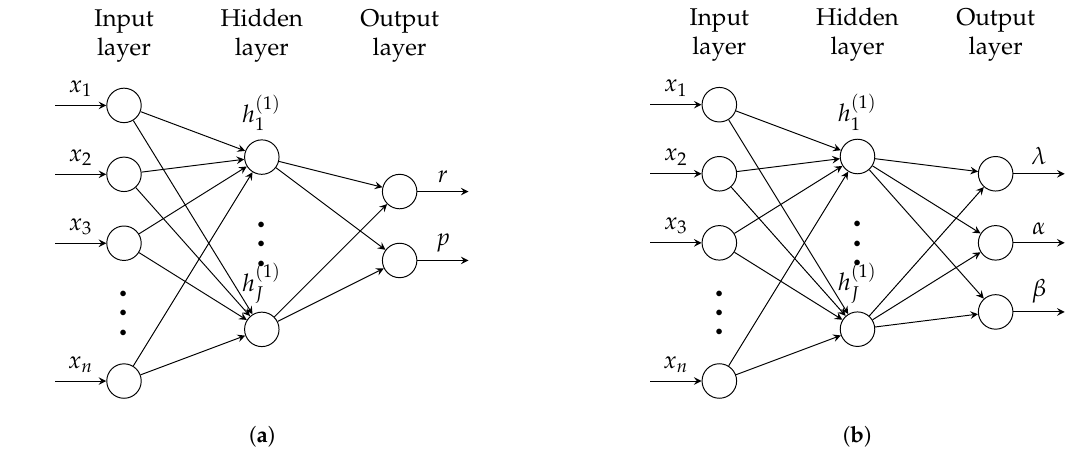
Figure 7. Examples of alternate distributions in neural networks with the NLL approach. ( a ) Negative binomial neural network. ( b ) Tweedie neural network.